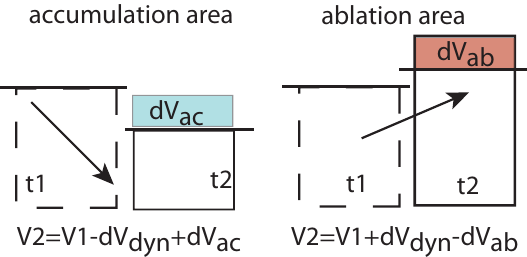
Fig. 2. The volume change dV = V 1 − V 2 at one location between two dates t 1 and t 2 is the result of ice flow dV dyn and mass balance. The downward motion in the accumulation area can result in a sub- sidence, although accumulation dV ac takes place. In the ablation area, the surface can lift although ablation takes place dV ab . With- out knowledge of the ice dynamics or the direct mass balance, it is not possible to separate these